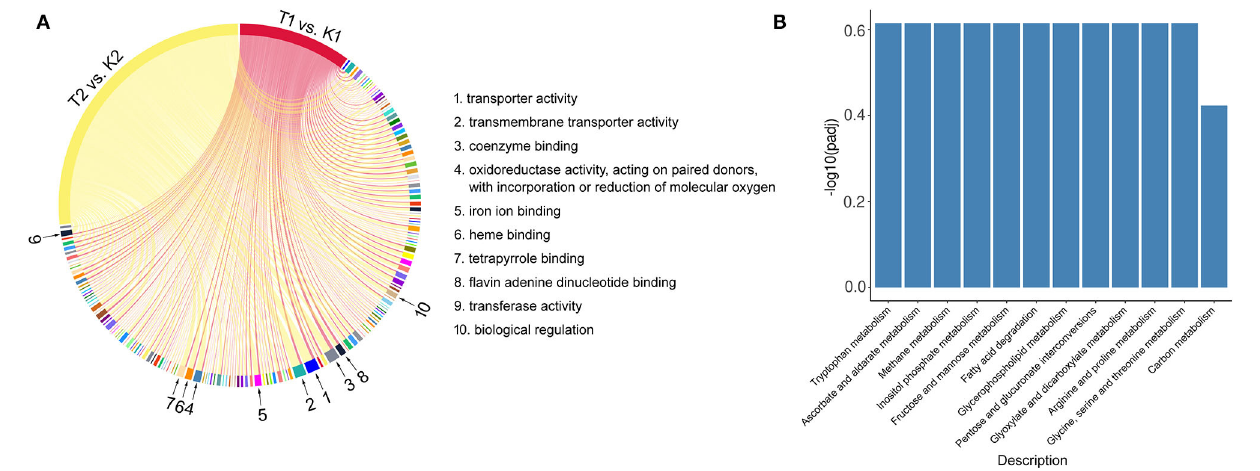
FIGURE 11 | The common terms and pathways of GO and KEGG enrichment in T1 vs. K1 and T2 vs. K2 comparison groups. (A) Chord diagram of common terms in GO richment analysis. (B) Histogram of common pathways in KEGG richment